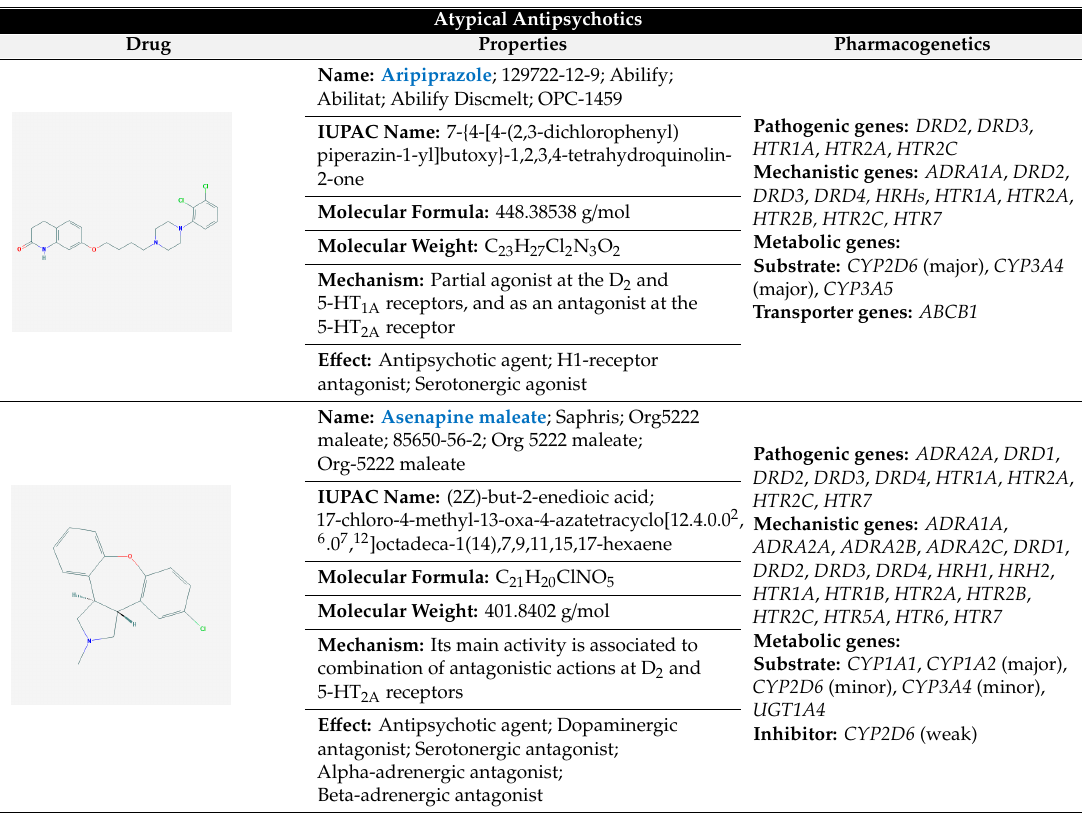
Table 3. Pharmacological profile and pharmacogenetics of selected antipsychotics.